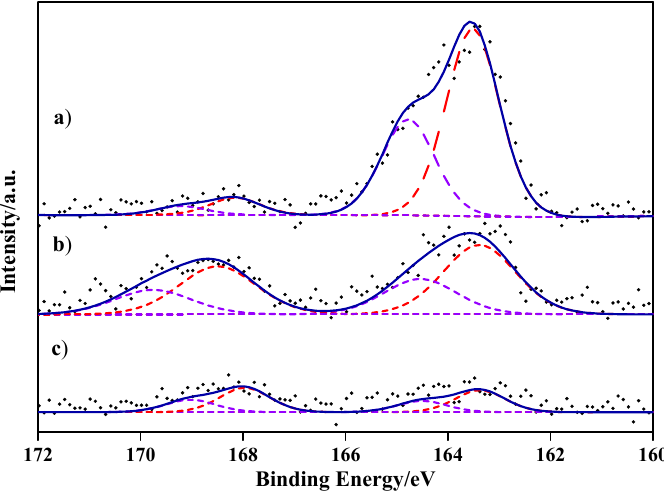
Figure 2. S 2p XPS spectra of samples T ( a ), TSu ( b ), and TS ( c ).